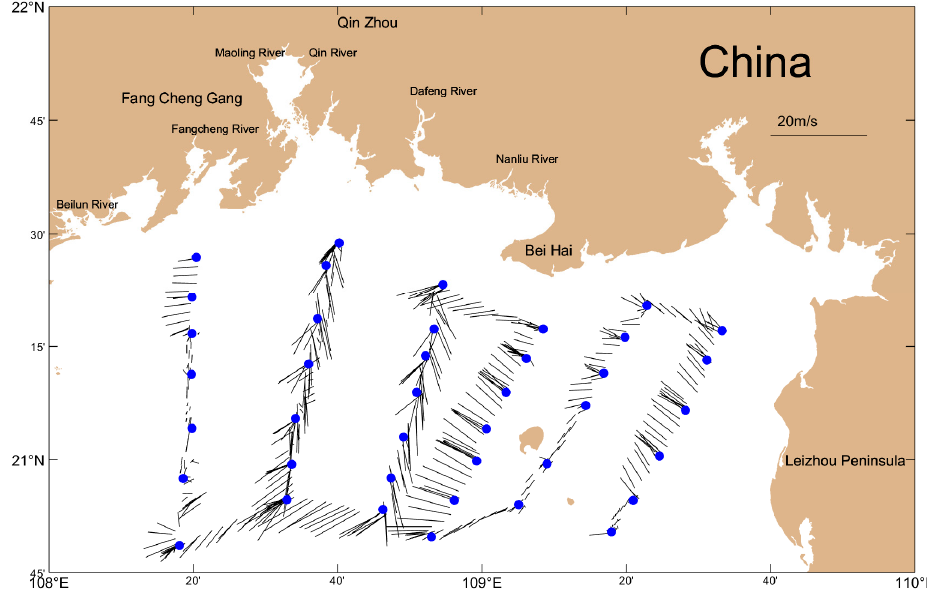
Figure 6. Distribution characteristics and changes in surface wind field during the sampling period in May 2021.